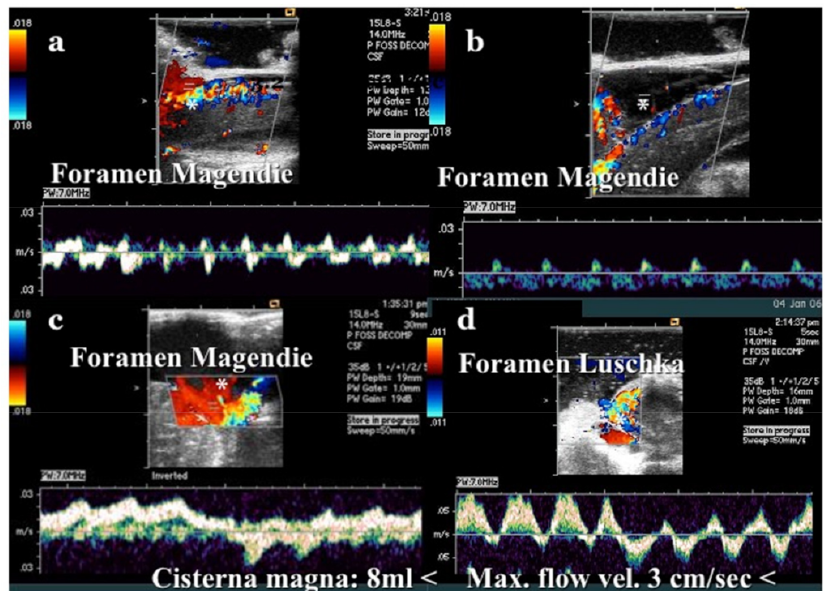
Figure 3. Illustrative cases: color Doppler ultrasonography (CDU). ( a ): CDU at the foramen of Magendie after craniotomy. The cerebrospinal fluid (CSF) space of the cisterna magna was very small. Low CSF stump flow was observed. ( b ): CDU at the foramen of Magendie after opening the dura mater. Although the CSF space became slightly larger than before opening, CSF flow was unchanged, and only low stump flow was observed. * CSF space. ( c ): CDU at the foramen of Magendie after expansive craniotomy and dural plasty. * CSF space. ( d ): CDU at the foramen of Luschka after dural plasty. CDU was performed immediately after craniotomy. In this case, the cisterna magna was small and CSF flow was low, so dural plasty was performed. After dural plasty, CDU was performed again. A sufficiently large wave of CSF flow was confirmed from the foramina of Magendie and